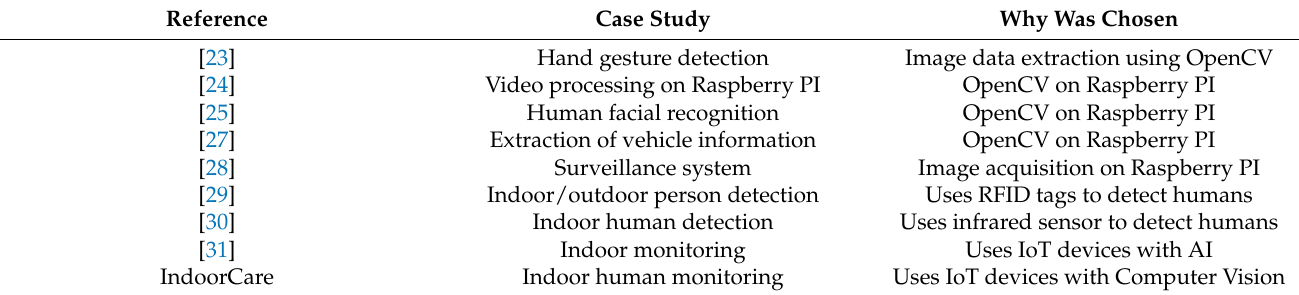
Table 1. Comparison between the solutions presented in the related work section. Reference Case